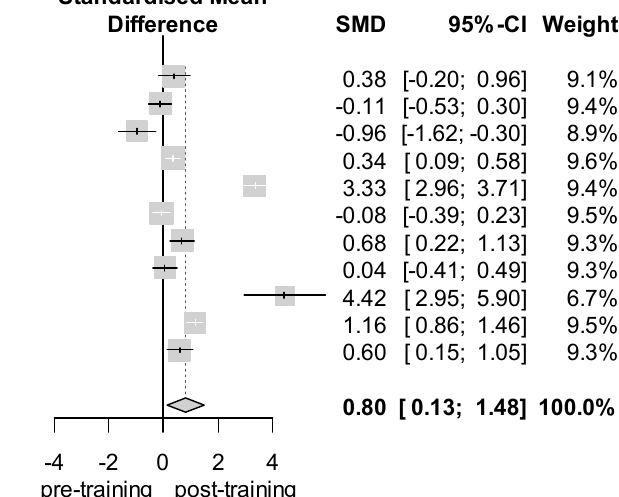
Figure 6. Forest plot—Self-reported practice.